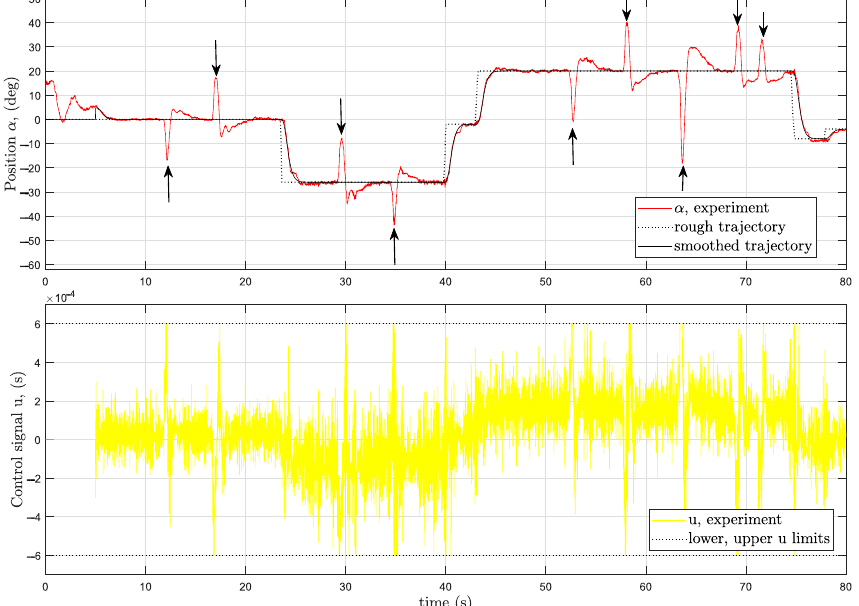
Figure 13. Experimental “qualitative” trajectory tracking measurement in the presence of external (manual) torque disturbance, Λ = 2.75 s − 1 . Start time instances of manual disturbances are marked with